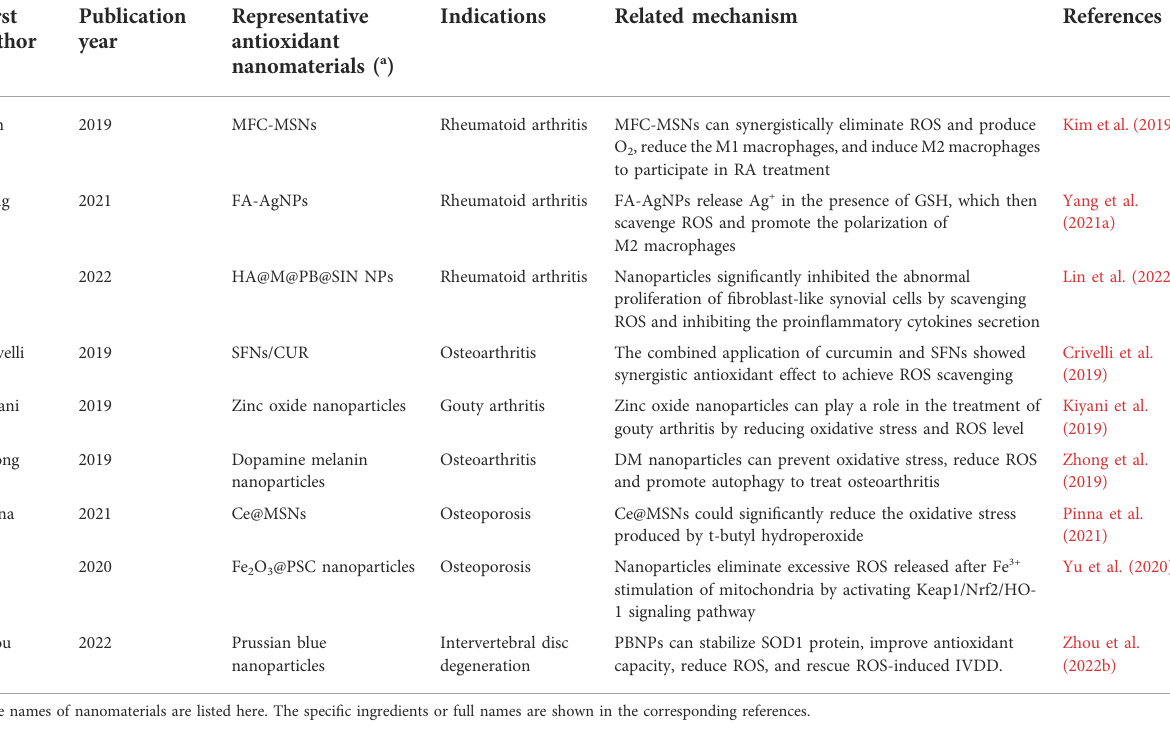
TABLE 2 Representative ROS scavenging nanomaterials for orthopaedic diseases.